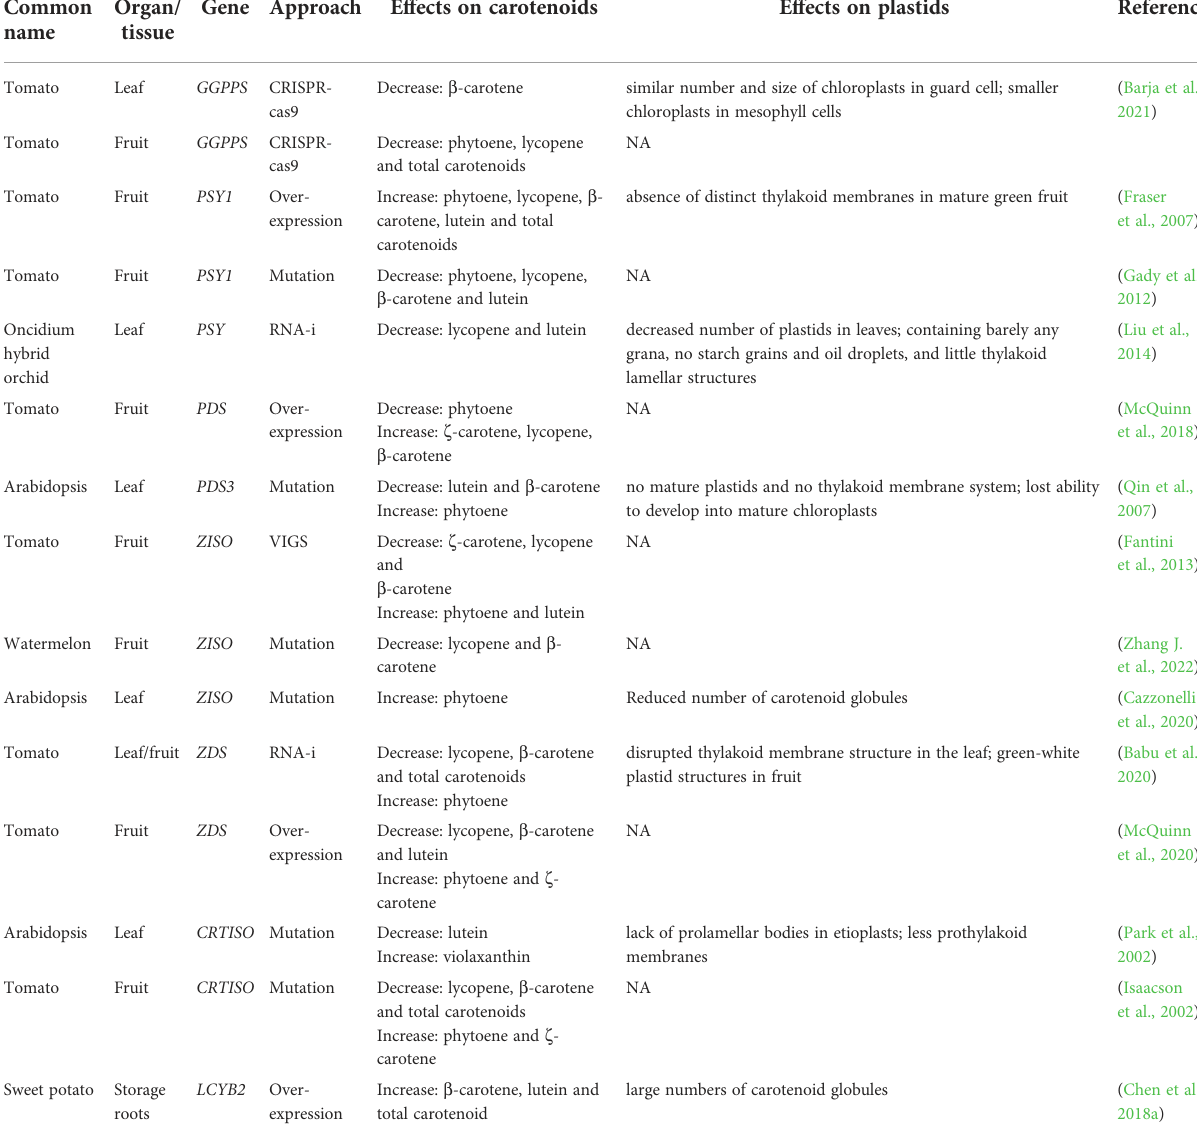
TABLE 2 Effects of different carotenoid biosynthetic genes on carotenoid composition and content as well as plastid morphology. Common